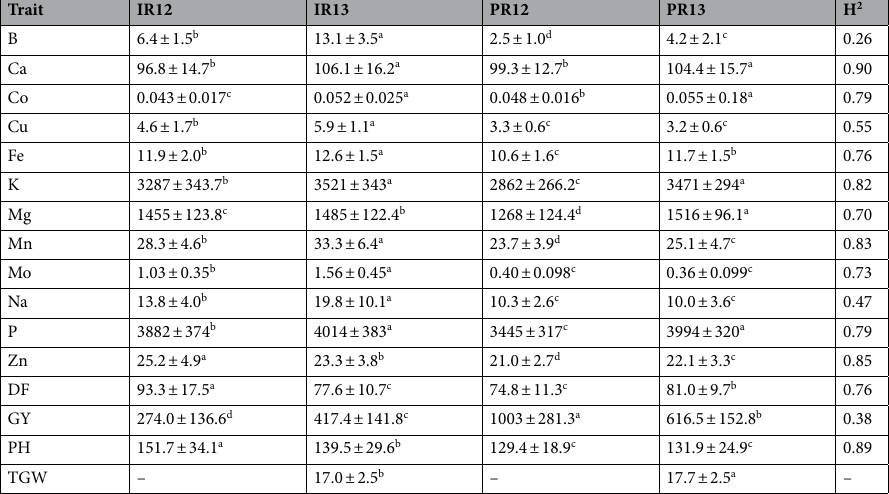
Table 1. Descriptive statistics of agronomic and grain element traits in the PRAY panel grown in four environments (IR12: IRRI 2012, IR13: IRRI 2013, PR12: PhilRice 2012, PR13: PhilRice 2013). Data represents the mean ± standard deviation. Different letters indicate statistically significant differences between growing environments at P < 0.05 (ANOVA, one-way, Bonferroni pairwise test). All element concentrations were expressed as mg kg −1 ; DF, days to 50% flowering; PH, plant height (cm); GY, grain yield (kg ha −1 ); TGW: thousand grain weight (mg); H 2 , broad-sense heritability; –, data not available.